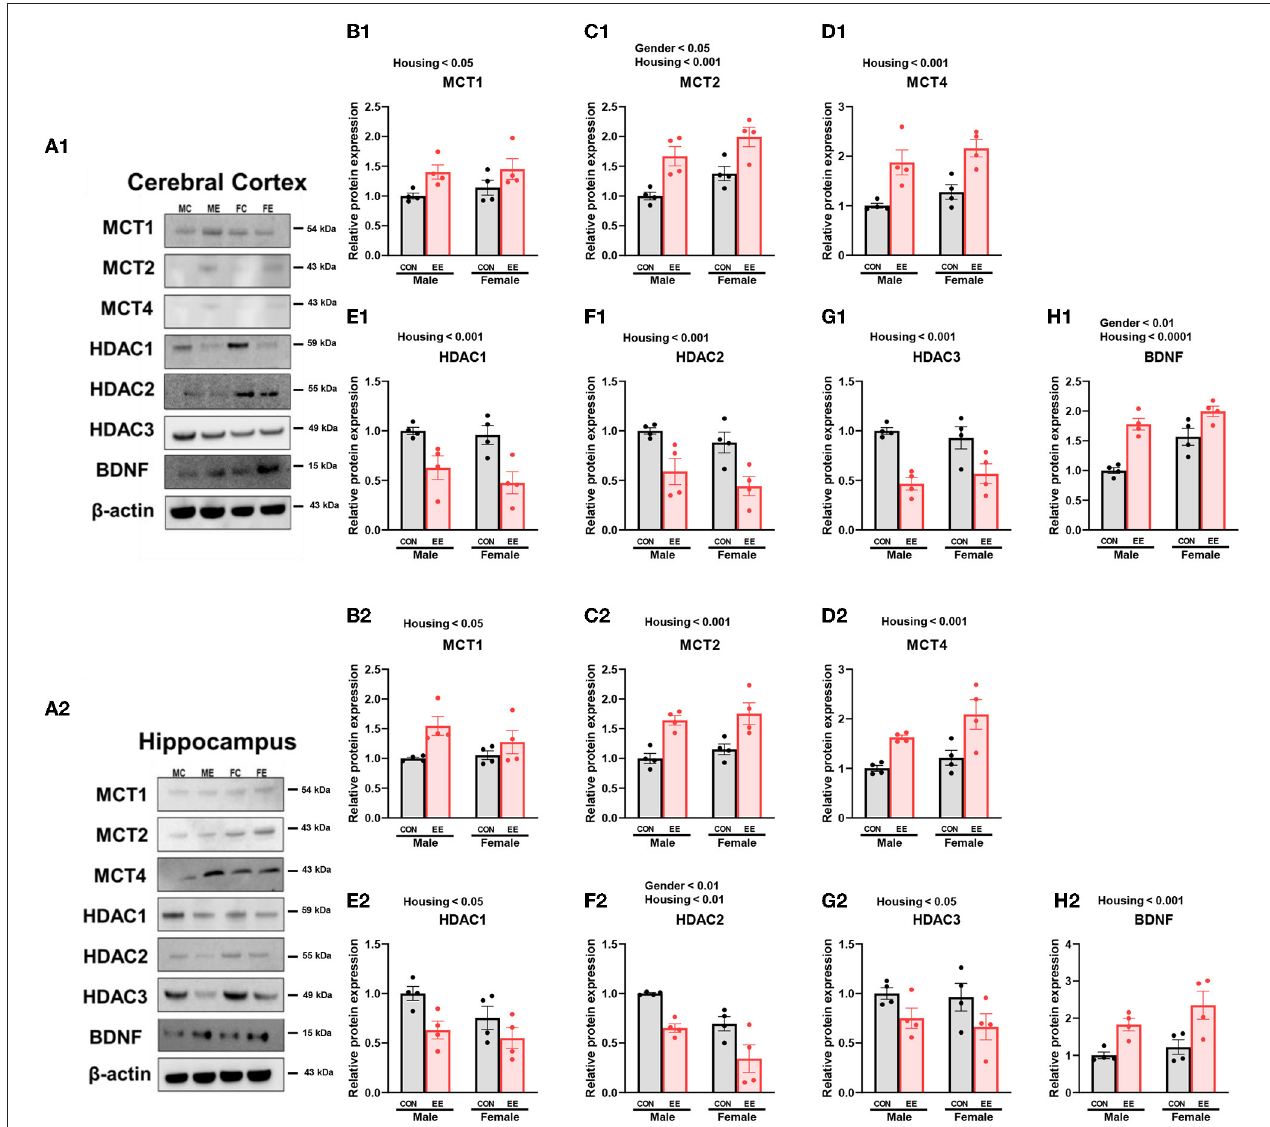
FIGURE 4 | Effects of EE on the expression of β HB-related proteins under the influence of estrogen by western blot. (A1–H1) Cerebral cortex and (A2–H2) hippocampus protein levels for β HB-related proteins measured using western blot ( n = 4 per group). Two-way ANOVA with Tukey multiple comparison test. Significant sex effect, significant housing effect, and the significant interaction between sex and housing were noted with p -value. Data represented are means ±